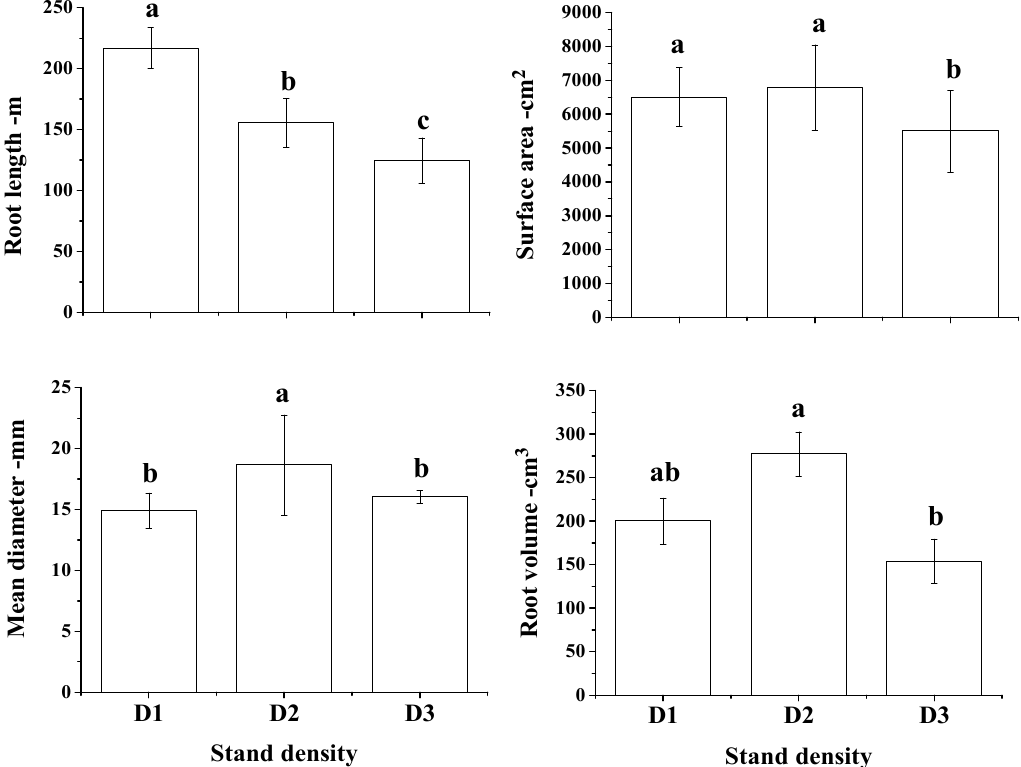
Figure 5. Root morphological traits of Chinese fir trees planted in low (D1), intermediate (D2) and high (D3) initial stand density. Values are mean ± SE, and bars with the same letter(s) for each treatment are not significantly different at the 0.05 level of probability.